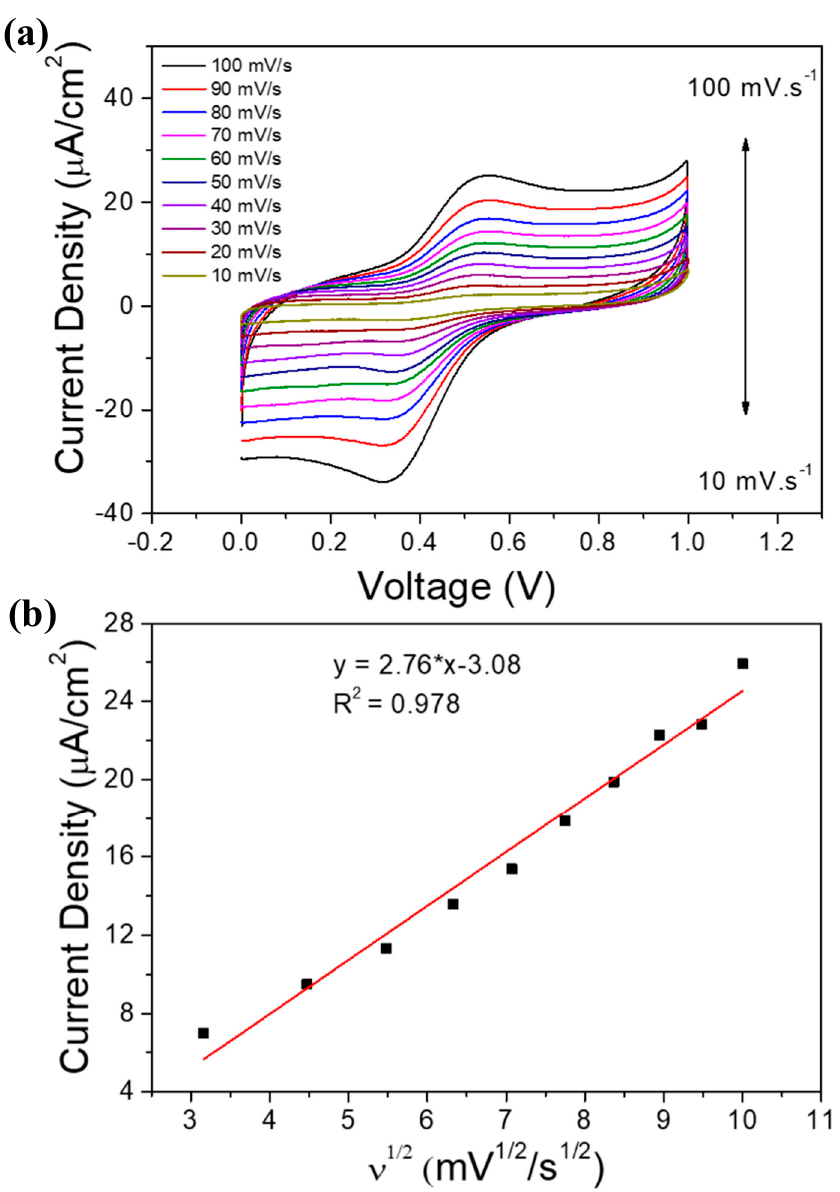
Figure 7. ( a ) CV curves for Fe 3 O 4 / GCE in di ff erent scan rate (10, 20, 30, 40, 50, 60, 70, 80, 90, and 100 mV.s − 1 ) in 0.5 mM of glucose in 0.1 M of PBS solution pH 7.4; ( b ) linear regression plot for the increasing scan rate.